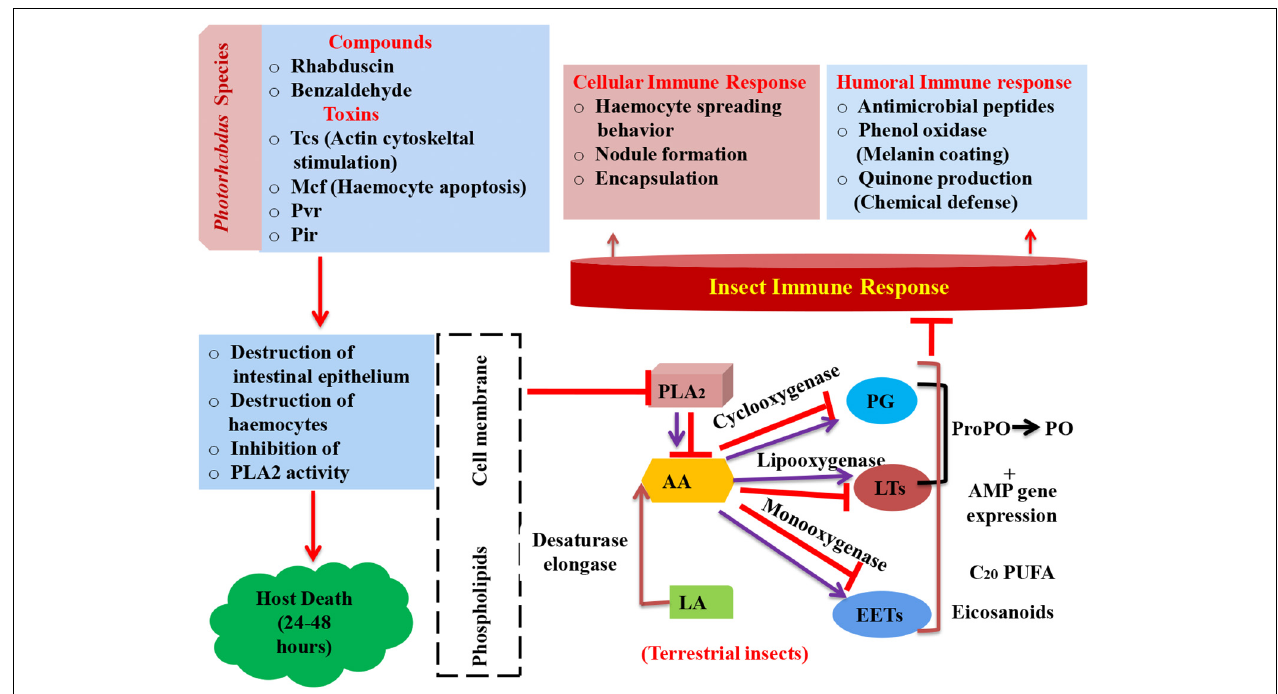
FIGURE 2 | Schematic representation of insect’s immune response and mode of action of Photorhabdus compounds in arresting immune system leading to mortality (PLA2, phospholipase A2; AA, arachidonic acid; LA, linoleic acid; PG, prostaglandin; LTs, leukotrienes; EETs, epoxyeicosatrienoic acids; ProPO, prophenoloxidase; AMP, antimicrobial peptides; PO, phenol oxidase; Tcs, toxin complexes; Mcf, make caterpillars floppy; Pvc, Photorhabdus virulence cassettes; Pir, insect-related